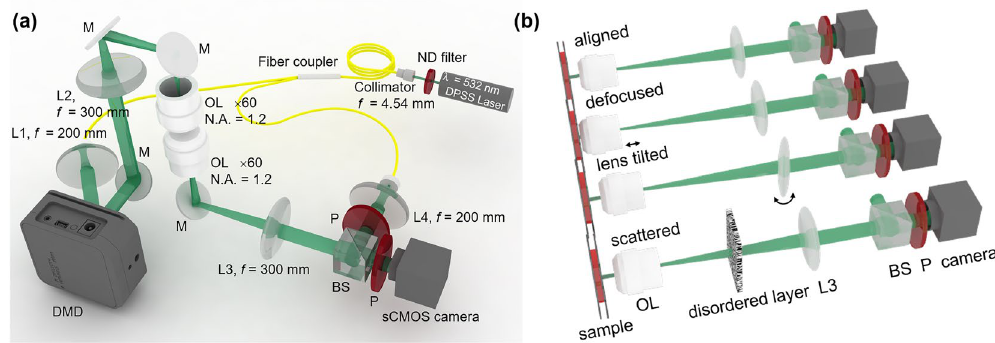
Figure 6. The experimental optics setup. ( a ) An inverted microscope based on Mach-Zehnder interferometry. A sample is loaded between the condenser and imaging objective lenses. L: lens; M: mirror; OL: objective lens; BS: beam splitter; P: polarizer ( b ) Imposition of various aberration conditions on the imaging system, including optical defocus and lens tilt, and insertion of weakly scattering media in the optic